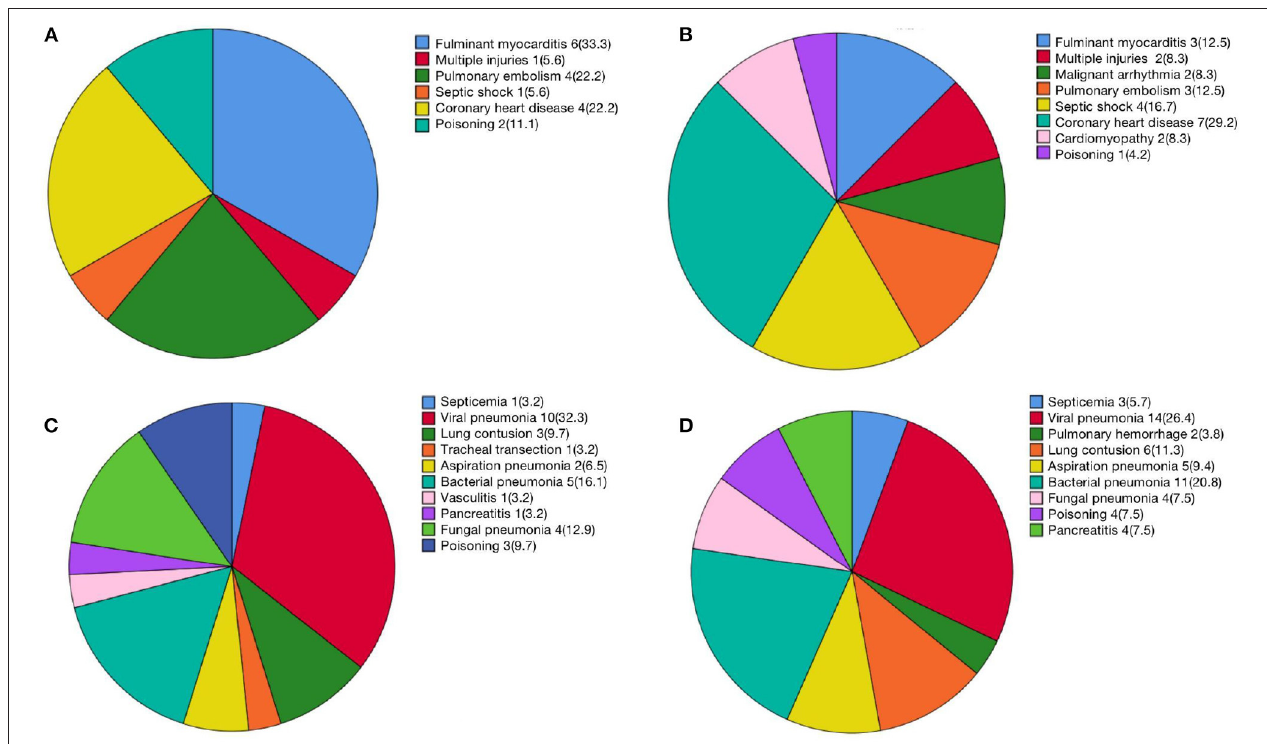
FIGURE 2 | Numbers and percentages of ECMO indications. (A) VA-ECMO survivors; (B) VA-ECMO non-survivors; (C) VV-ECMO survivors; (D) VV-ECMO non-survivors.